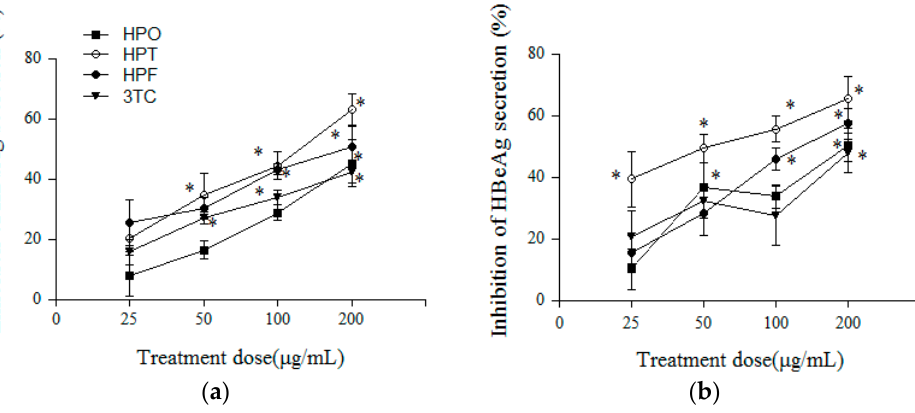
Figure 3. Inhibitory effects of HPO, HPT, HPF and 3TC on HBsAg and HBeAg secretion from HepG2.2.15 cells. HepG2.2.15 cells were treated with HPO, HPT, HPF and 3TC (25, 50, 100, and 200 μ g/mL) in 96-well culture plates at 37 °C in 5% CO 2 . After six days, the levels of ( a ) HBsAg and ( b ) HBeAg in the culture supernatants were detected with commercial ELISA kits. * p < 0.01 vs. (3TC) control.